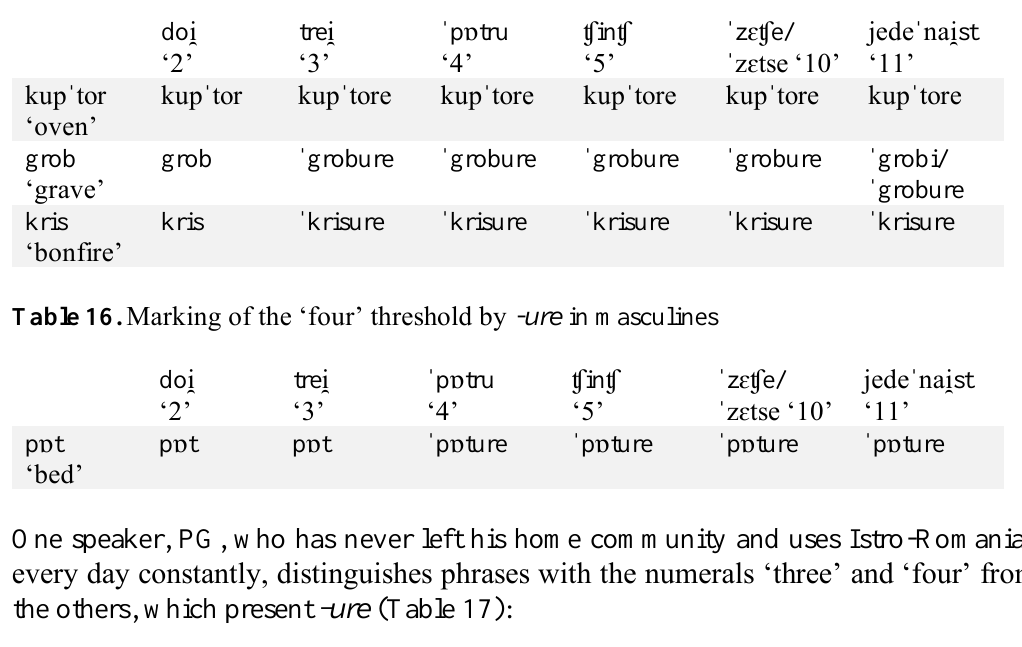
Table 15. Marking of the ‘three’ threshold by -e or more commonly - ure in masculines